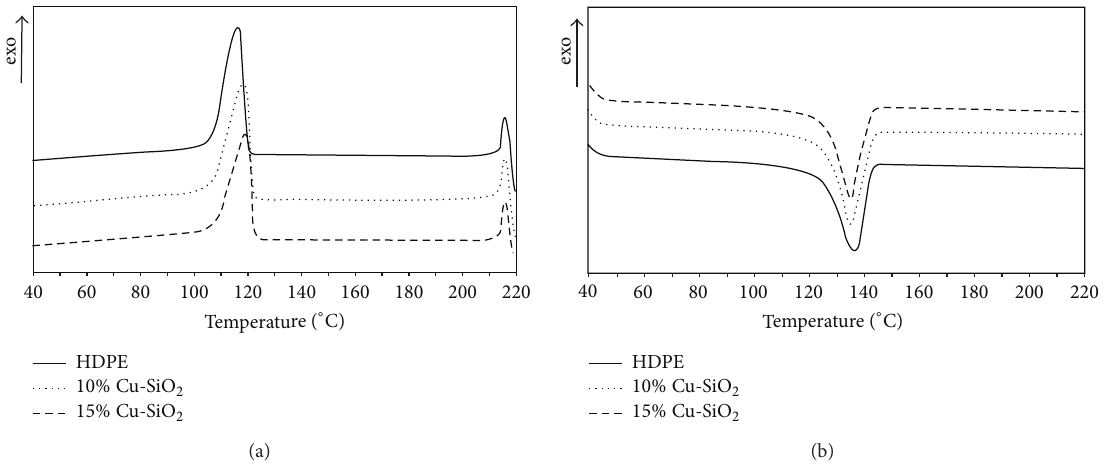
Figure 7: DSC curves of HDPE and nanosilica containing immobilized nanocopper filled HDPE composites: second heating (a) and cooling run